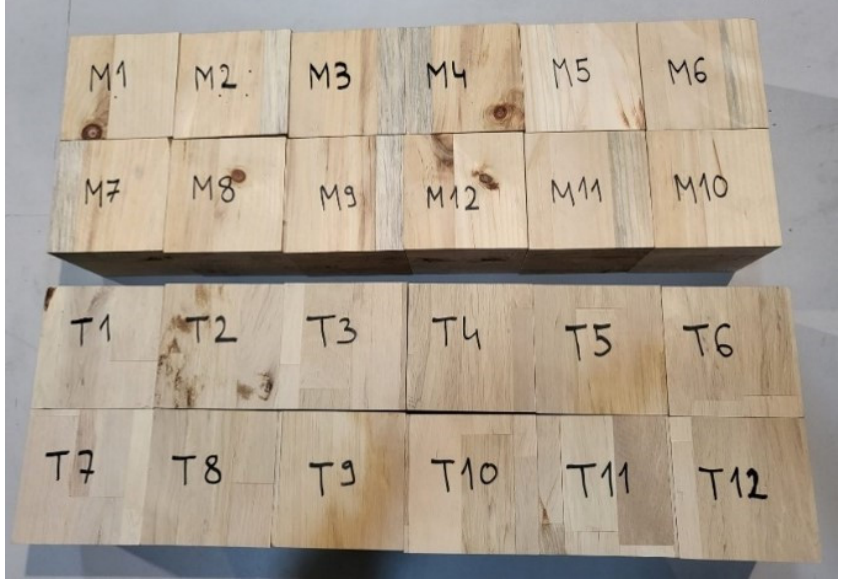
Table 1. Density of cube specimens.